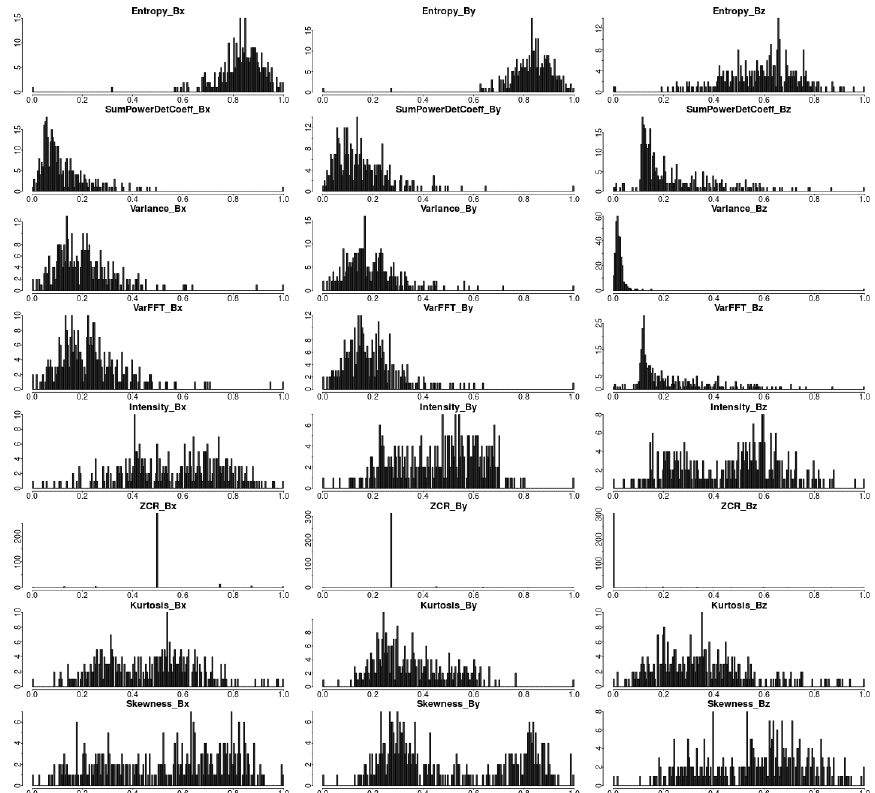
Figure 5. Distribution of features extracted from the data collected in Building A after being pre-processed. Table 2. Optimum number of clusters proposed by each clustering algorithm for Building